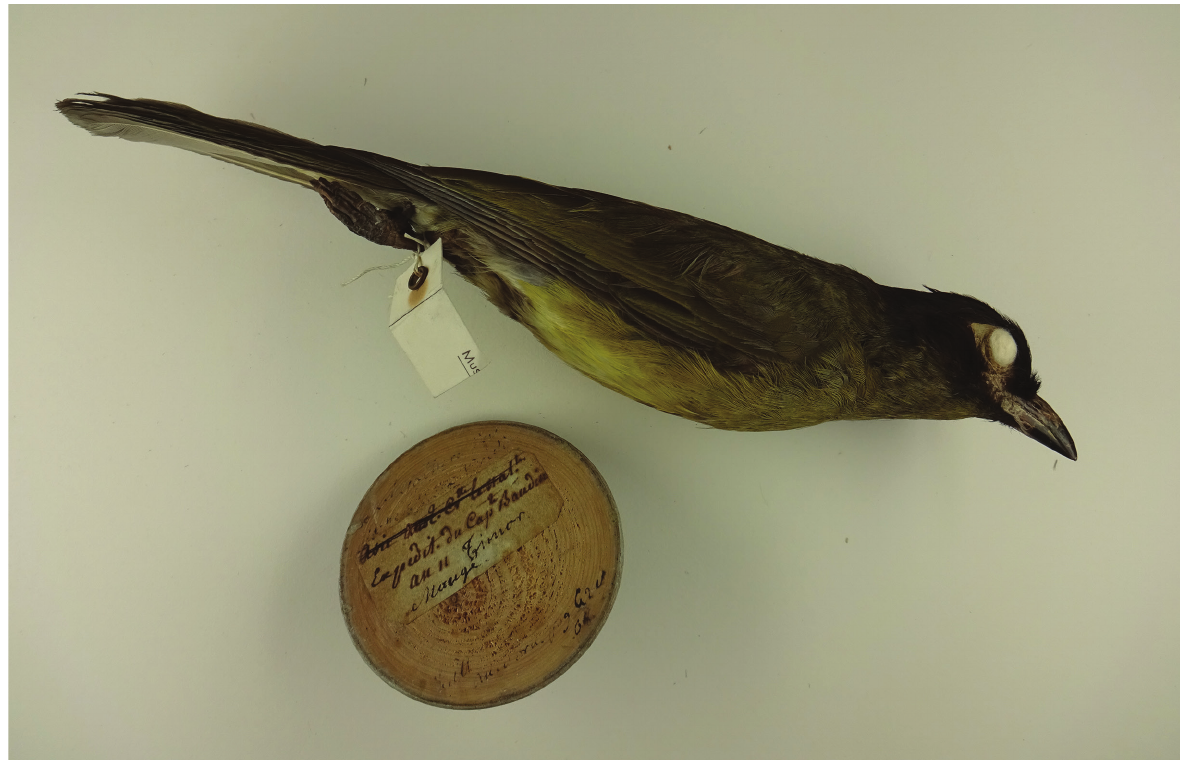
Figure 2. MNHN-ZO-2012-677: See figure 2. In addition, Timor is later added in another hand.